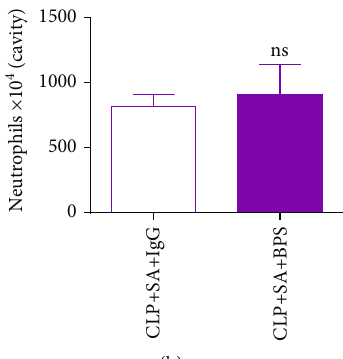
Figure 4: (a, b) Gating strategy to analyze total cells within BALF. (c, d) Gating of CD11b+F4/80+ cells was conducted to determine overall macrophage count within BALF. (e, f) Gating of CD4+ cells was conducted to determine overall T lymphocyte count within BALF. (g, h) Gating of CD11b+Ly6G+ cells was conducted to determine overall neutrophil count within BALF. Kaplan – Meier analysis and log-rank tests were conducted to compare two groups. ∗ p < 0 : 05 , ∗∗ p < 0 : 01 , compared with secondary S. aureus pneumonia in septic mice treated with the isotypical IgG